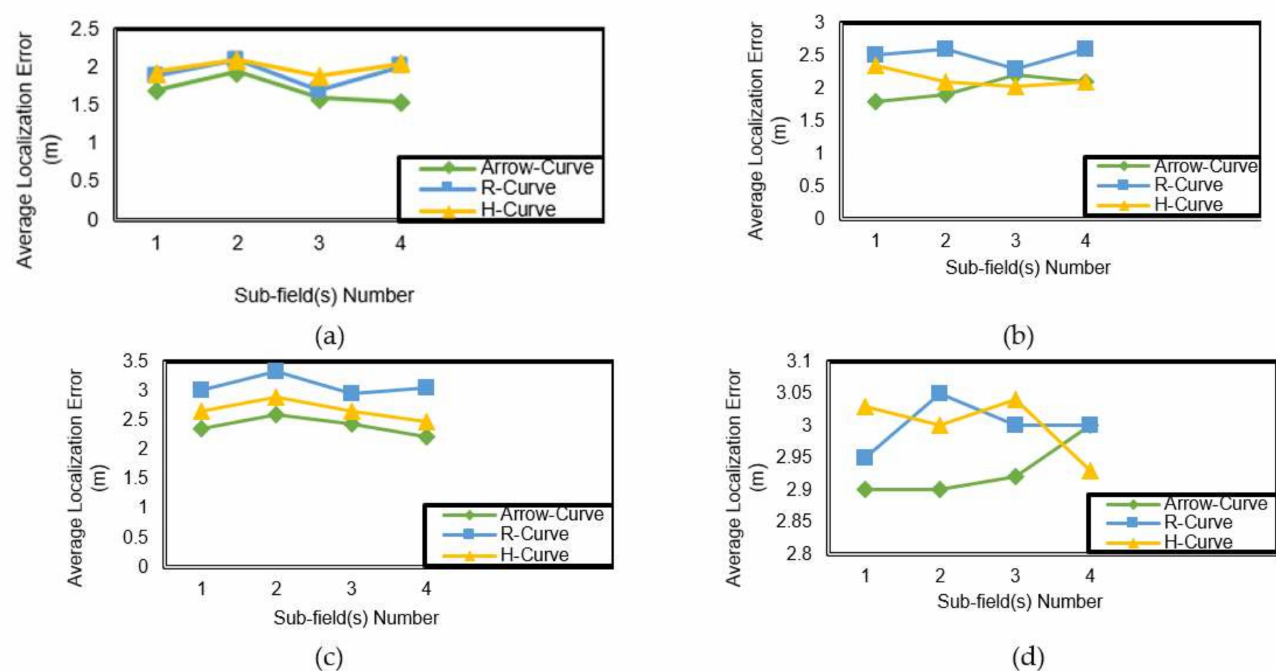
Figure 12. Average localization error (m) corresponding to sub-field (S) number at resolution (L): ( a ) L = 10.; ( b ) L = 12.5; ( c ) L = 15; ( d ) L = 17.5.